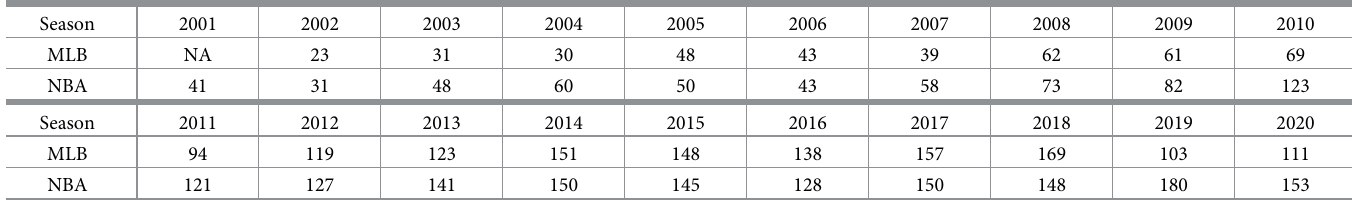
Table 5. The number of MLB and NBA players in the final dataset, which contains those players who switched to a different team and had a Twitter account.